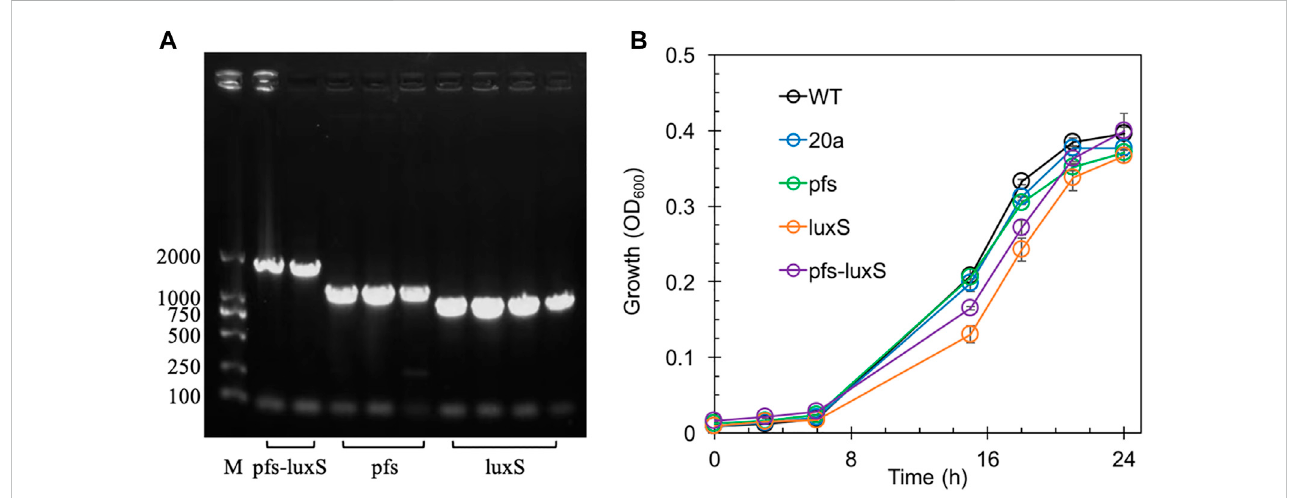
FIGURE 2 The con fi rmation of genes manipulation (A) and growth pro fi les of transformants and wildtype Z. mobilis (B) . M stands for DNA marker DL 2000.